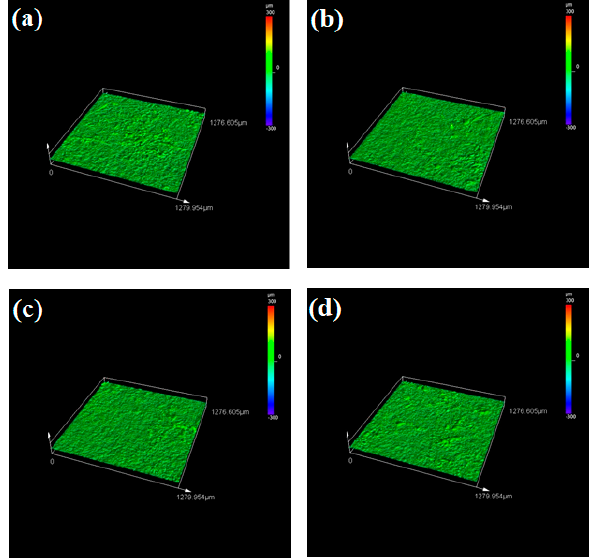
Figure 12. 3D surface plots obtained using laser microscope after the corrosion test for the cladded samples at ( a ) 0 h, ( b ) 18 h, ( c ) 42 h and ( d ) 70 h.